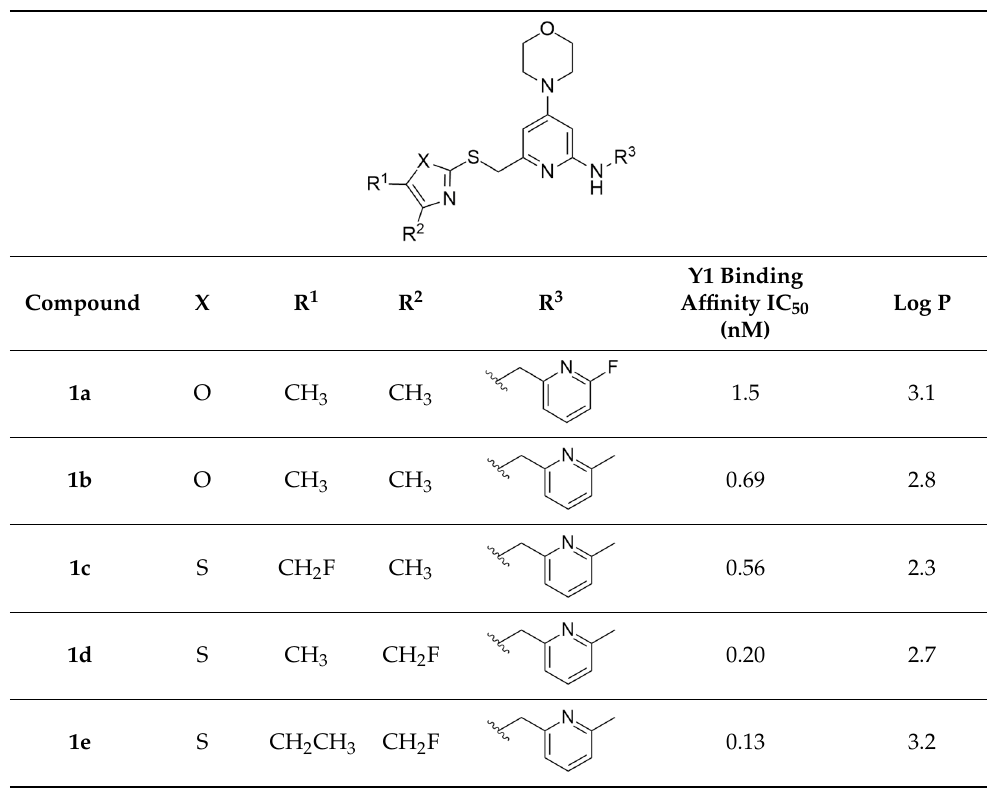
Table 3 . SAR of compounds 1a – e .